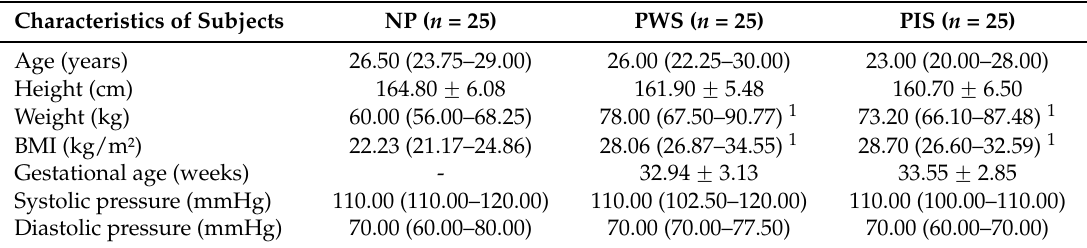
Table 1. Clinical and demographic characteristics of pregnant and non-pregnant women. Characteristics of